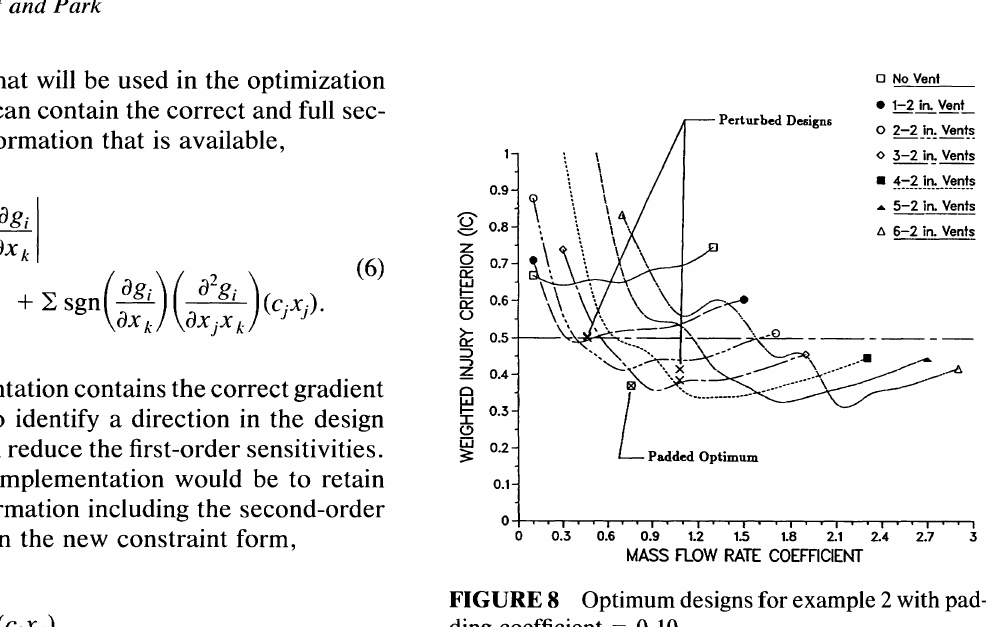
FIGURE 8 Optimum designs for example 2 with pad ding coefficient =